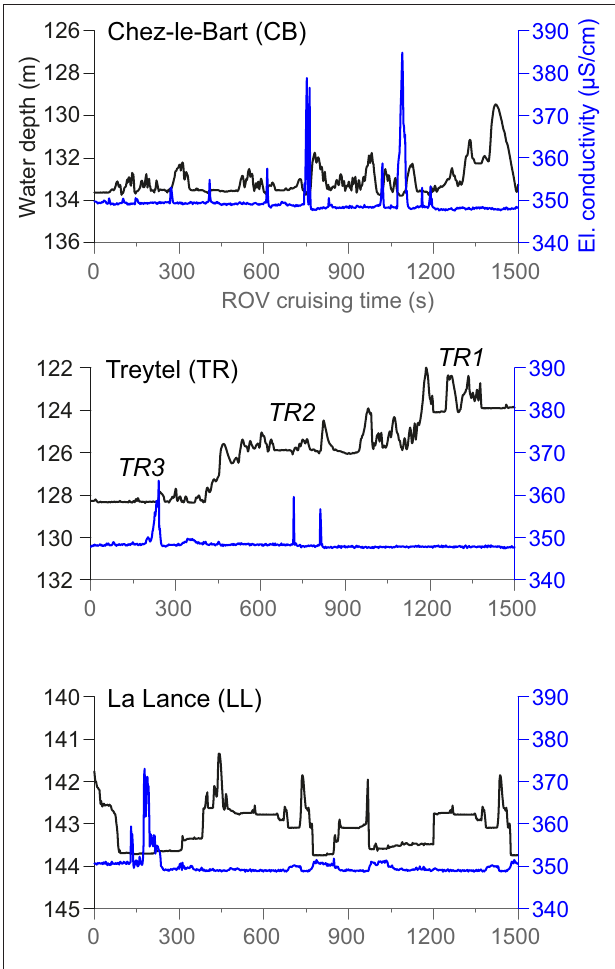
FIGURE 5 | Data of the CTD probe that was mounted on the ROV during the survey for the CB, TR, and LL pockmarks. The x-axis corresponds to the cruising time of the ROV, shown are the most interesting 25min (1500s); the y-axes show the depth of the ROV in the water and the electrical conductivity of the